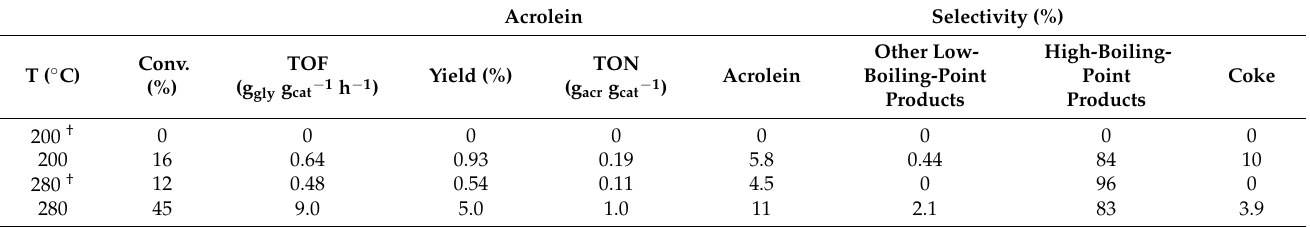
Table 2. Effect of reaction temperature on liquid-phase dehydration of glycerol over ZSM-5_280. a